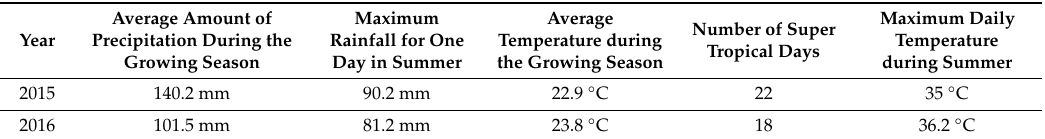
The average rainfall and temperatures in Hurbanovo in 2015 and 2016 during the growing